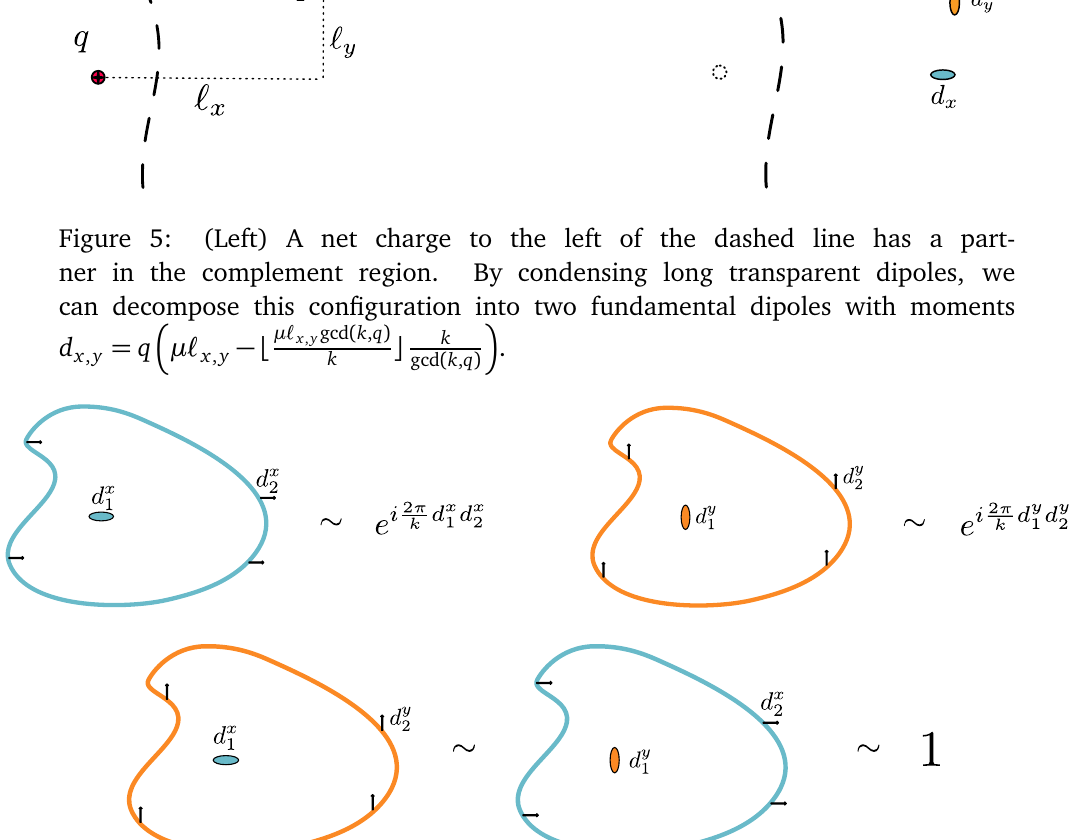
Figure 6: A dipole string operator wrapping around a dipole of the same orientation results in a phase reminiscent of anyon statistics. Dipoles of orthogonal orientations are mutually